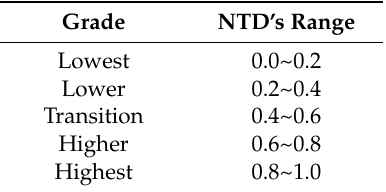
Table 3. Classification level based on the range of NTD.